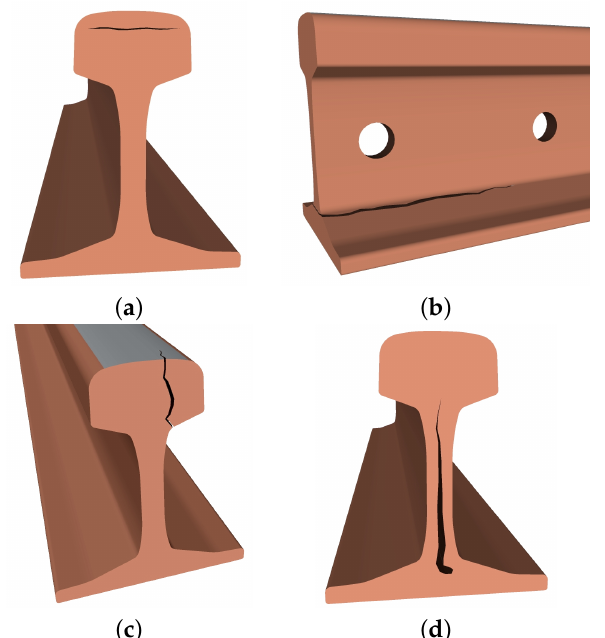
Figure 3. Three-dimensional representation of longitudinal defects: ( a , b ) horizontal fissures; ( c , d ) vertical